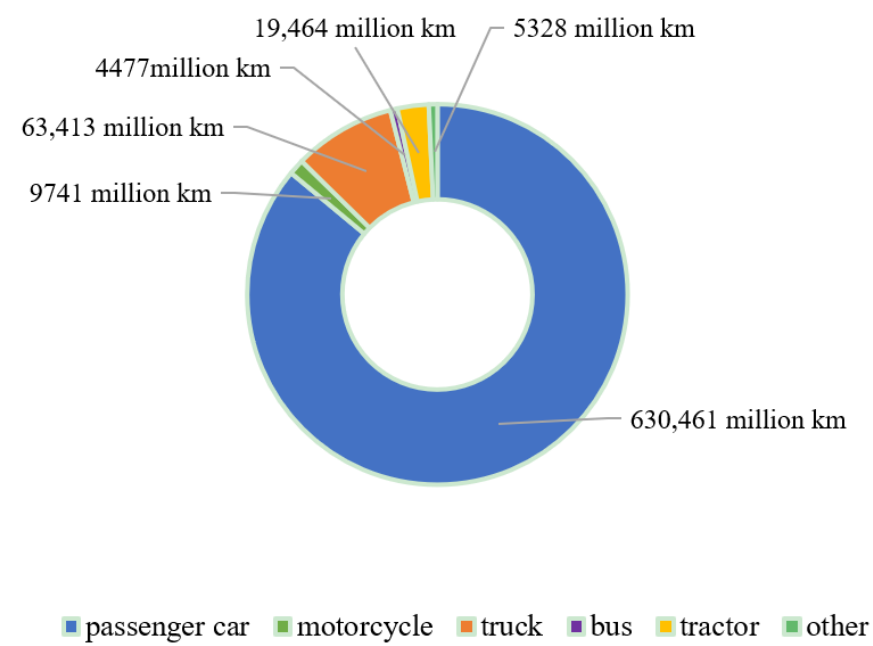
Figure 1. Total annual mileage in Germany [19].